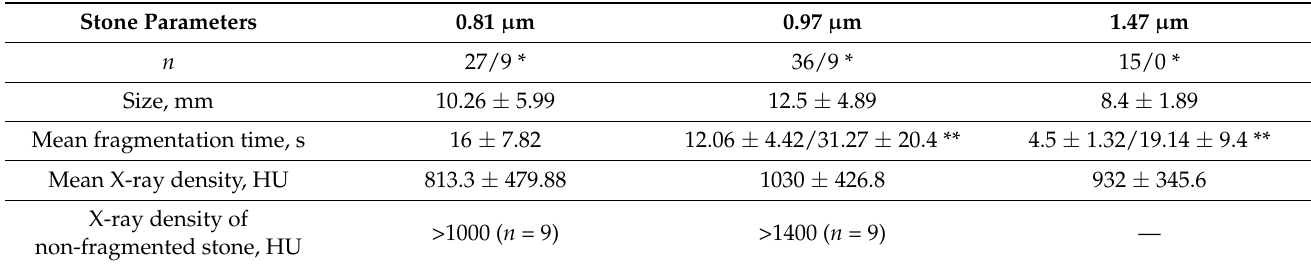
Table 2. Stone Table 2. Stone parameters.